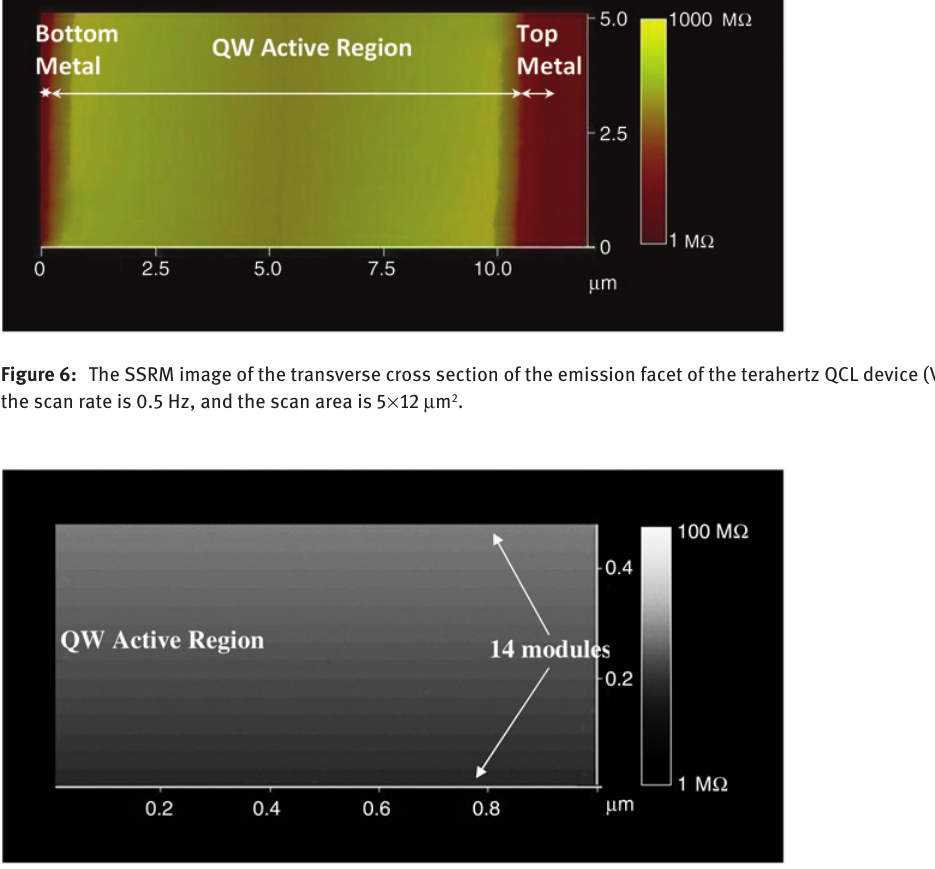
lateral distance from the top metal contact in Figure